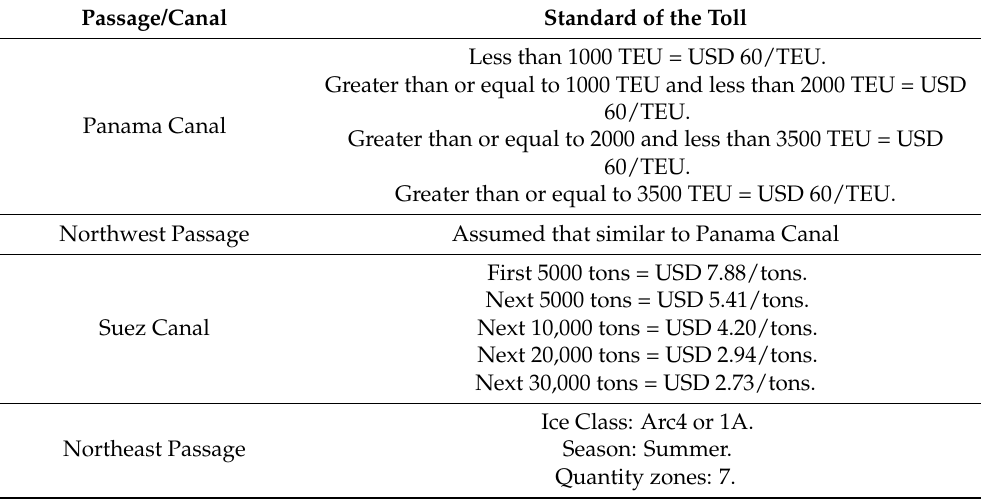
Table 1. Sea route tolls through arctic passages and the existing Panama and Suez